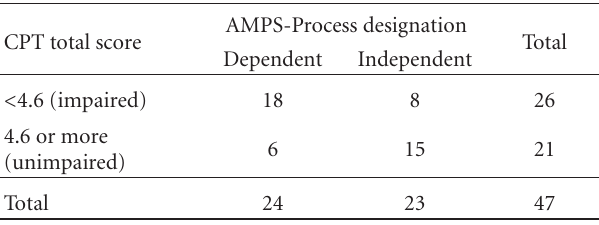
Table 4: Designation of functional impairment: Phi test of CPT and